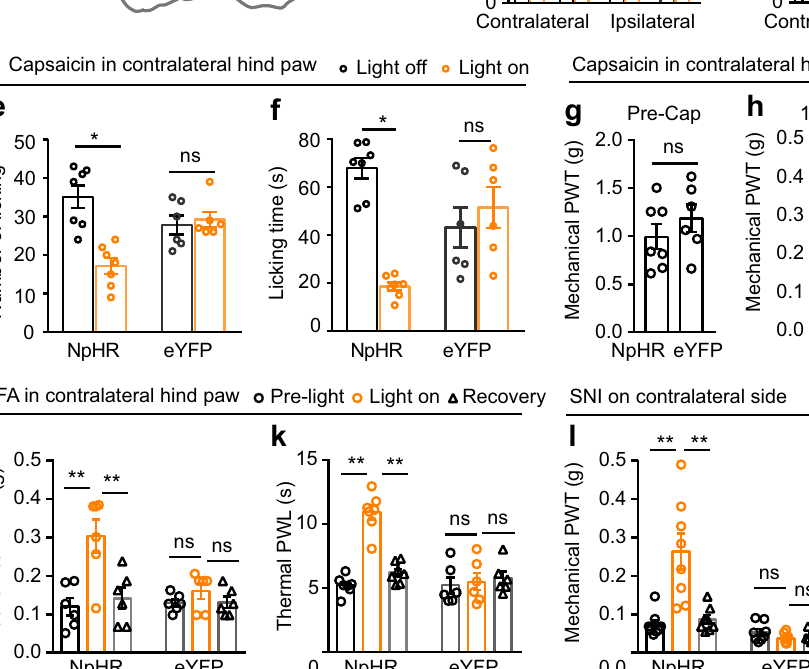
Fig. 8g – j). These effects are similar to the effect that the STN – LPB projection exerts on LPB neurons.